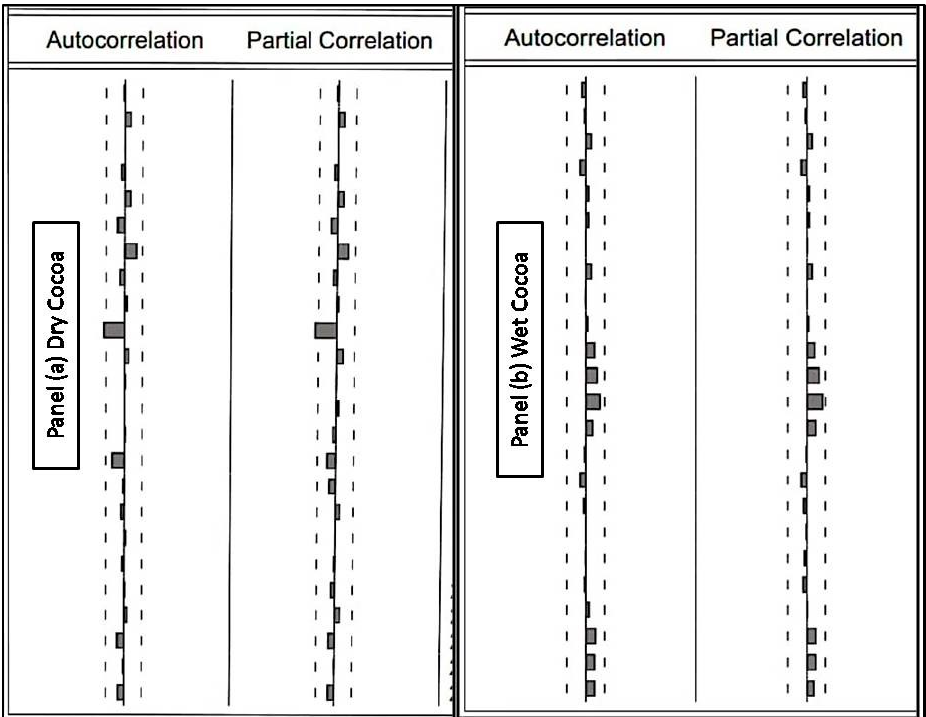
Figure 4. ACF and PACF correlograms for the residuals of (1, 1, 0) and (1, 1, 2) models. Source: Authors processing using EViews package.